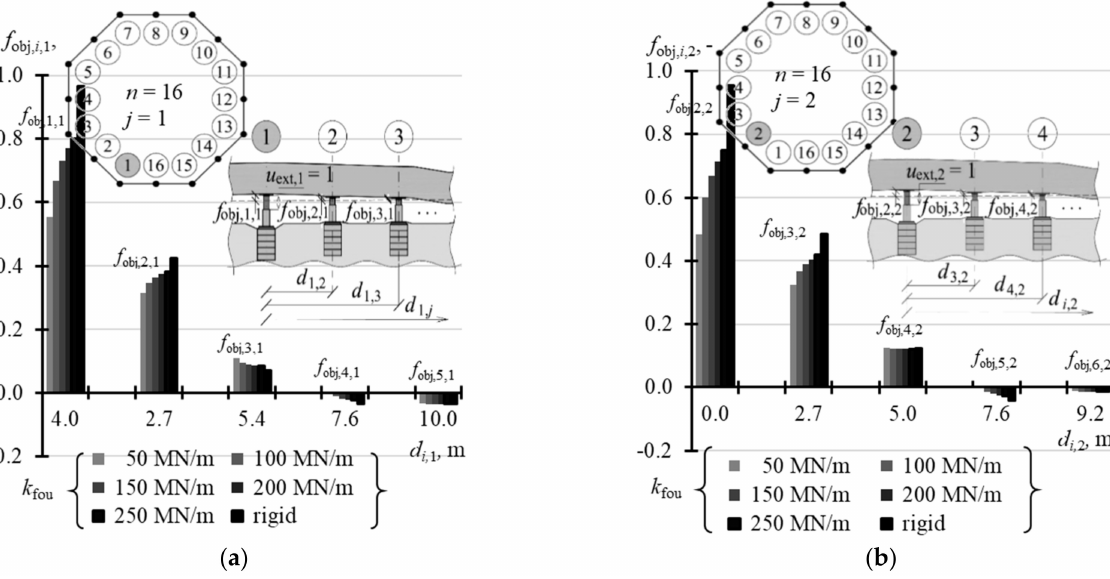
Figure 19. Elements of the matrix f obj for different stiffness values k fou of the jack support when n = 16: ( a ) elements f obj ,i, 1 ; ( b ) elements f obj ,i, 2